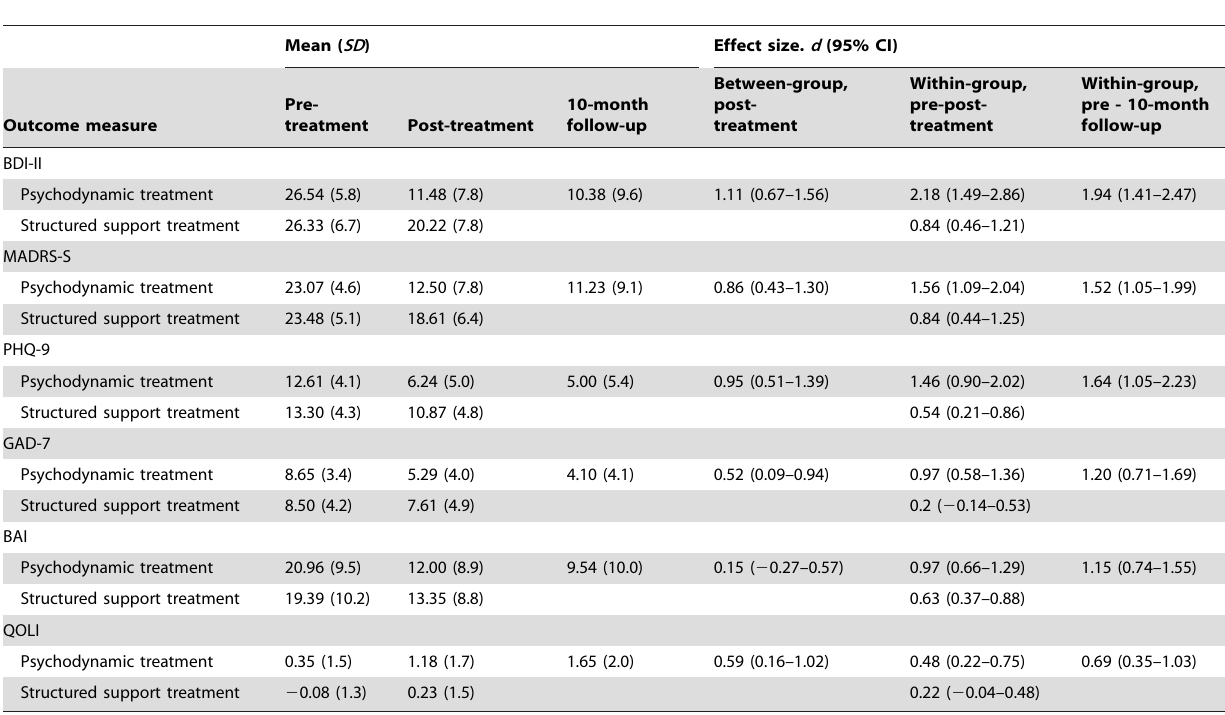
Table 2. Means, SDs and effect sizes (Cohen’s d) for measures of depression, anxiety and quality of